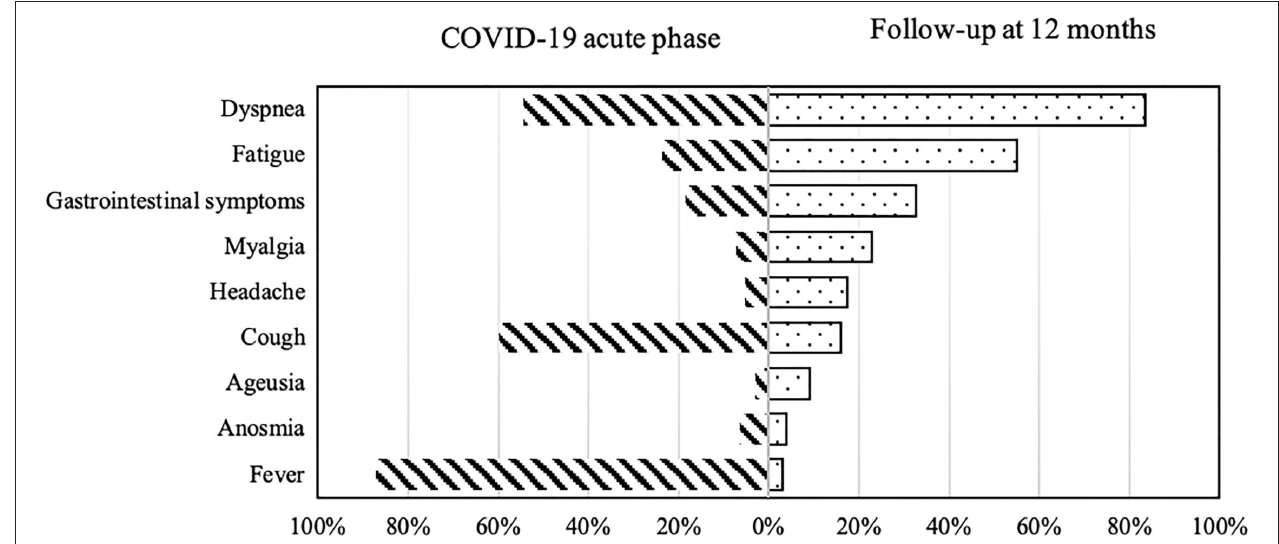
FIGURE 2 | COVID-19-related symptoms during the acute phase of illness (on the left) and at 12-months follow-up (on the right).